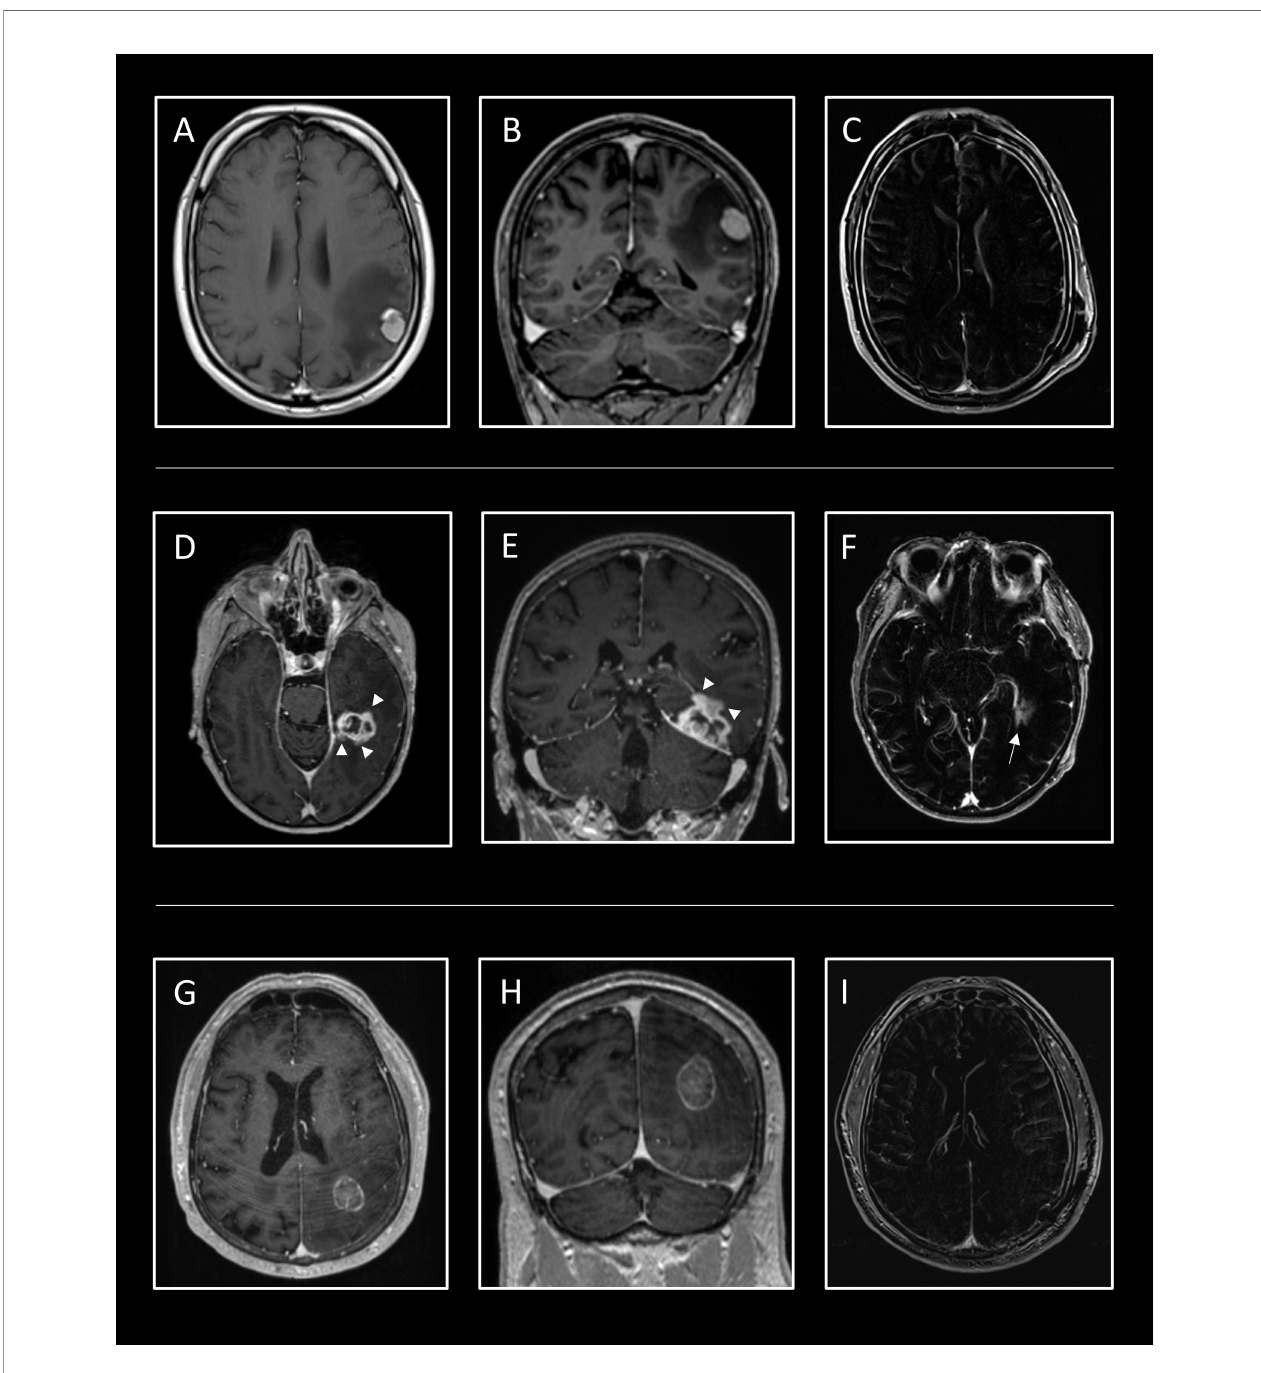
FIGURE 4 | Case examples for the application of the regression tree. In the fi rst line, the case of a 56-year-old man is shown who presented to the emergency department with an epileptic seizure and aphasia. Cerebral MRI showed a homogeneous contrast-enhancing cortical tumor in the parietal lobe with a volume of 2.2ml and extensive perifocal edema (A, B) . The risk of uSTR is very low at 4.8%, thus a GTR was con fi rmed in the postoperative T1 subtraction sequence (C) . Additionally, the preoperative aphasia improved. The second case shows a 69-year-old woman whose temporal metastasis of esophageal carcinoma grew progressively to 9.5ml despite radiation (D, E) . Neurological examination revealed mild aphasia. Detailed analysis revealed an irregular/diffuse contrast agent enhancement (white arrowheads), which, in combination with a distance of 15.4mm from the cortex, indicates a high risk of an uSTR at 43.2%. The aphasia improved postoperatively, but a residual tumor (white arrow) of 0.6ml (EOR rel = 94%) was detected (F) . At the bottom, the MRI of a 70-year-old man who suffered from ataxia and visual disturbance presents a subcortical tumor in the parietal lobe with a volume of 9.0ml (G, H) . The tumor has circumscribed contrast agent enhancement, with 11mm distant from the cortex, thus the risk for uSTR is moderate at 15.4%. Postoperatively, the ataxia and visual impairment improved and a GTR was obtained (I)